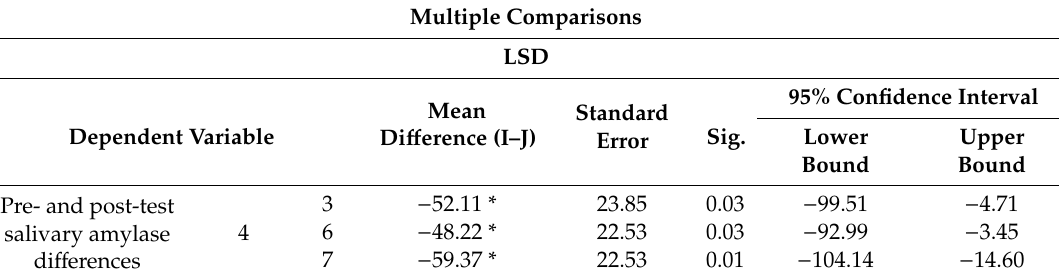
Table 4. Post-hoc multiple comparison of LSD with significant di ff erences in the salivary amylase of the ∆ D.